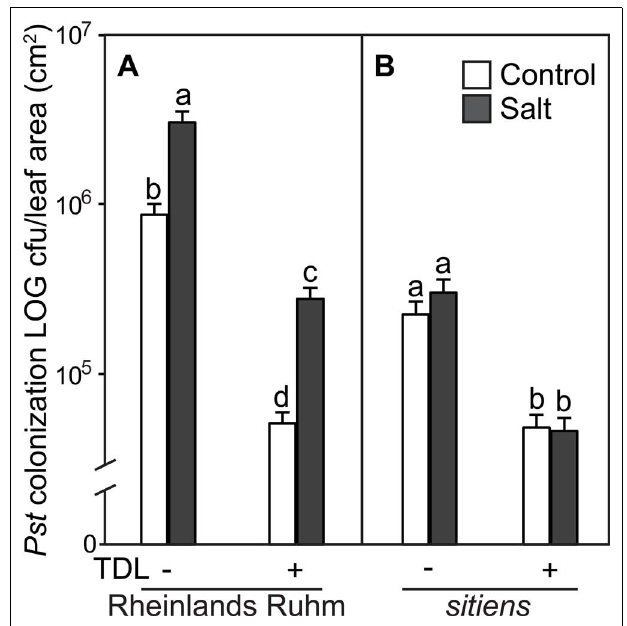
FIGURE 4 | Pseudomonas syringae pv. tomato colonization in (A)WT background (“Rheinlands Ruhm”) and (B) sitiens tomato leaves. Roots were pretreated withTDL for 7 days and then exposed for 18 h to salt stress (0.2 M NaCl/0.02 M CaCl 2 ). Shoots were dip-inoculated with a suspension of Pst adjusted to 10 7 cfu ml − 1 . Colonization was evaluated 4 dpi. Bars represent the means ± SE from three expriments, n = 15. Letters above bars indicate significant differences between treatments at α = 0.05 using theTukey–Kramer test for mean separation.